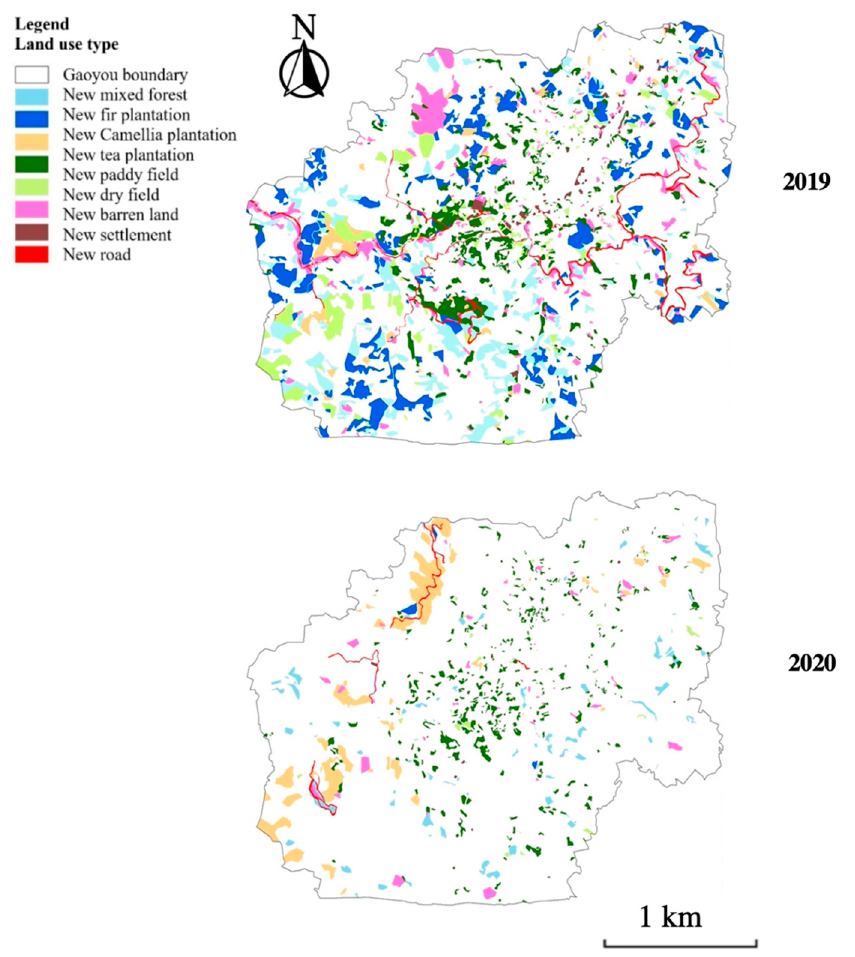
Figure 5. Maps of new changes in land use for 2019 and 2020.